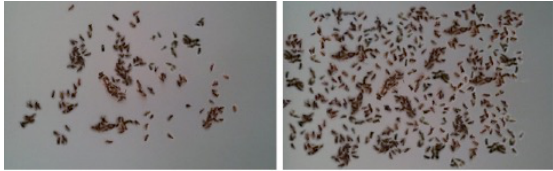
Figure 9. Example of the images in the